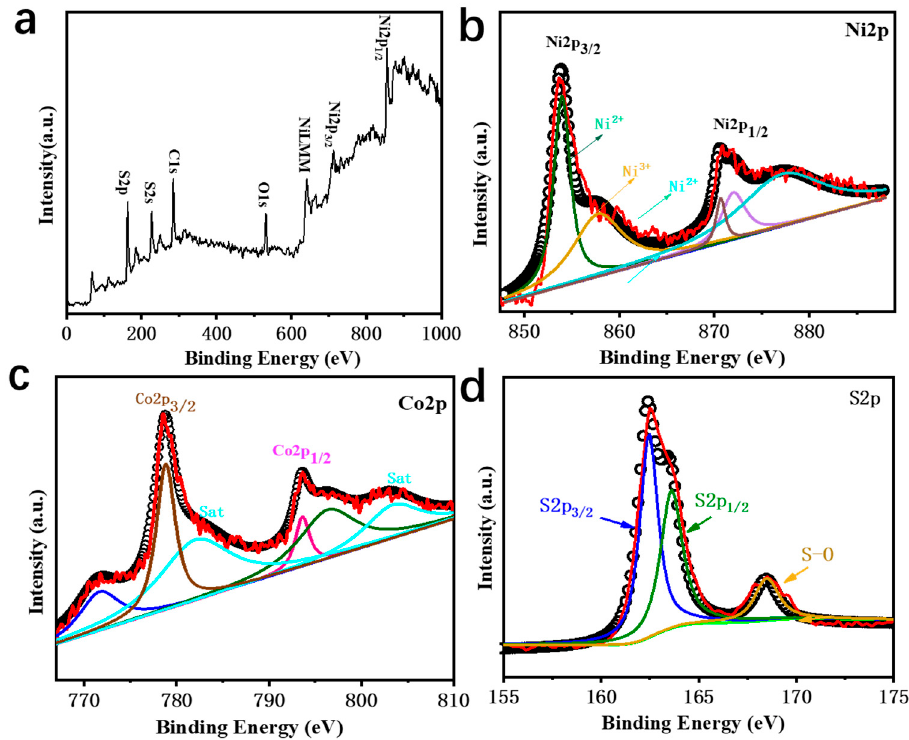
Figure 3. ( a ) Survey spectrum, and high-resolution; ( b ) Ni 2p; ( c ) Co 2p spectrum.; ( d ) S 2p spec-